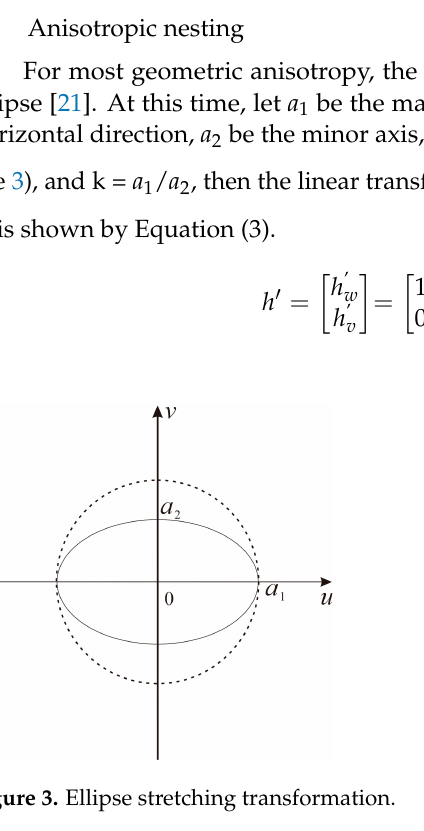
Figure 4. Coordinate axis rotation transformation. Figure 3. Ellipse stretching transformation.